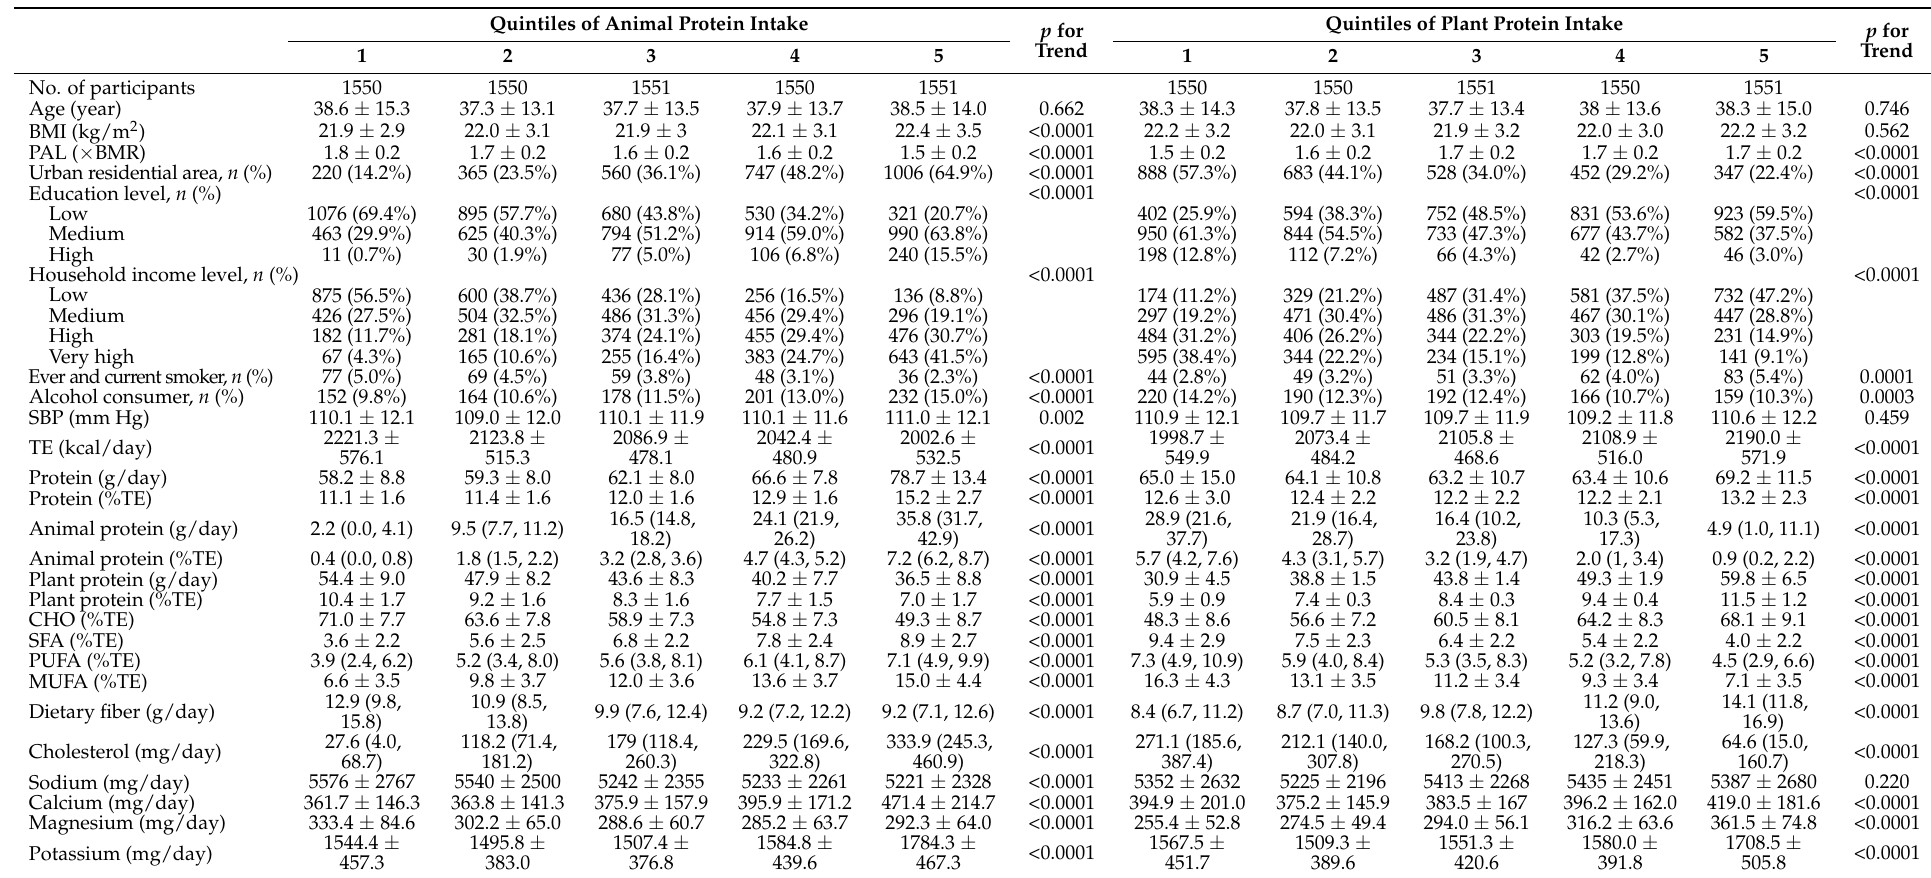
Table 2. Baseline sociodemographic and lifestyle factors and cumulative average dietary intakes in 7752 women according to quintiles of animal protein and plant protein intake 1